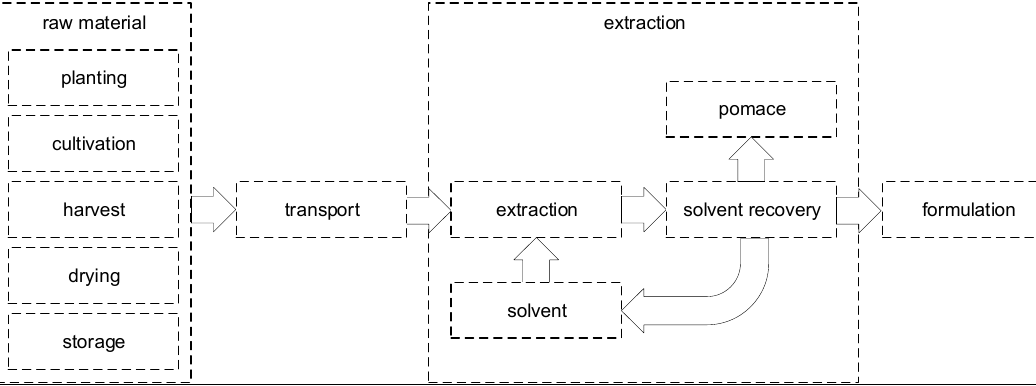
Figure 8. Supply chain for herbal raw materials.